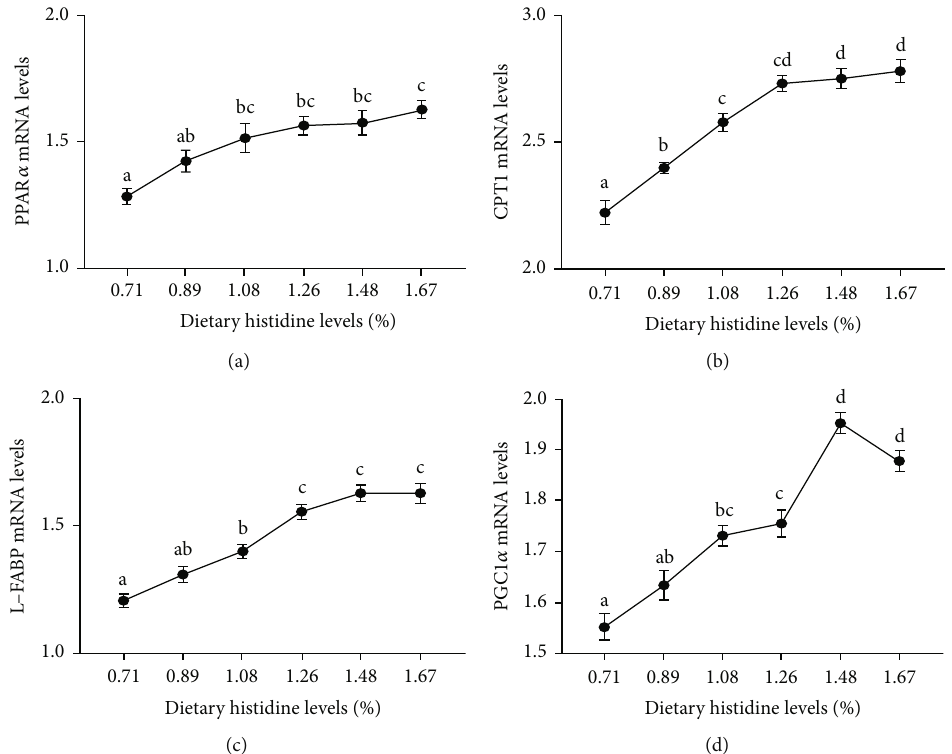
Figure 7: The relative expressions of PPAR α signaling pathway in liver of juvenile largemouth bass fed with di ff erent levels of dietary histidine. Data are expressed as means with S.E.M.; value with di ff erent superscripts are signi fi cantly di ff erent ( P < 0 : 05